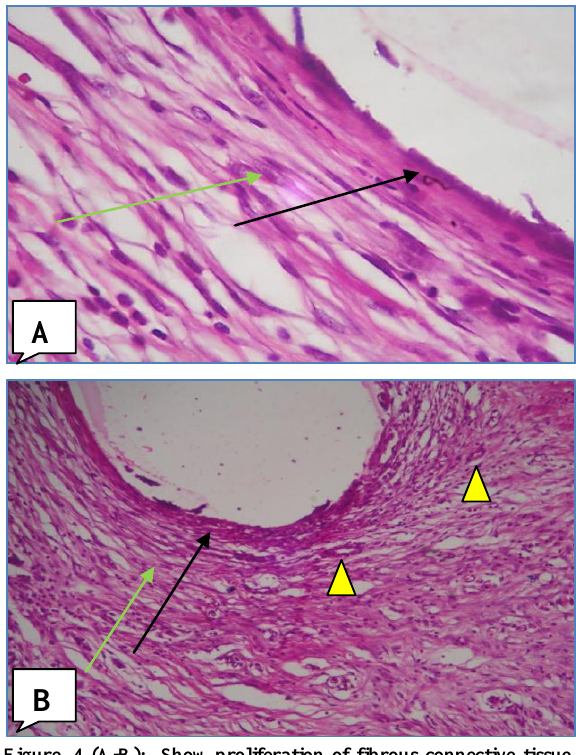
Figure, 4 (A-B): Show proliferation of fibrous connective tissue with MNCs infiltration together with remnant of thin epithelialization of incisional space , closure of the incisional space accompanied with appearance of congested blood vessels dddd with cellular infiltration, sutured by extra-mucosal pattern, 21 st days post operation (H and E,